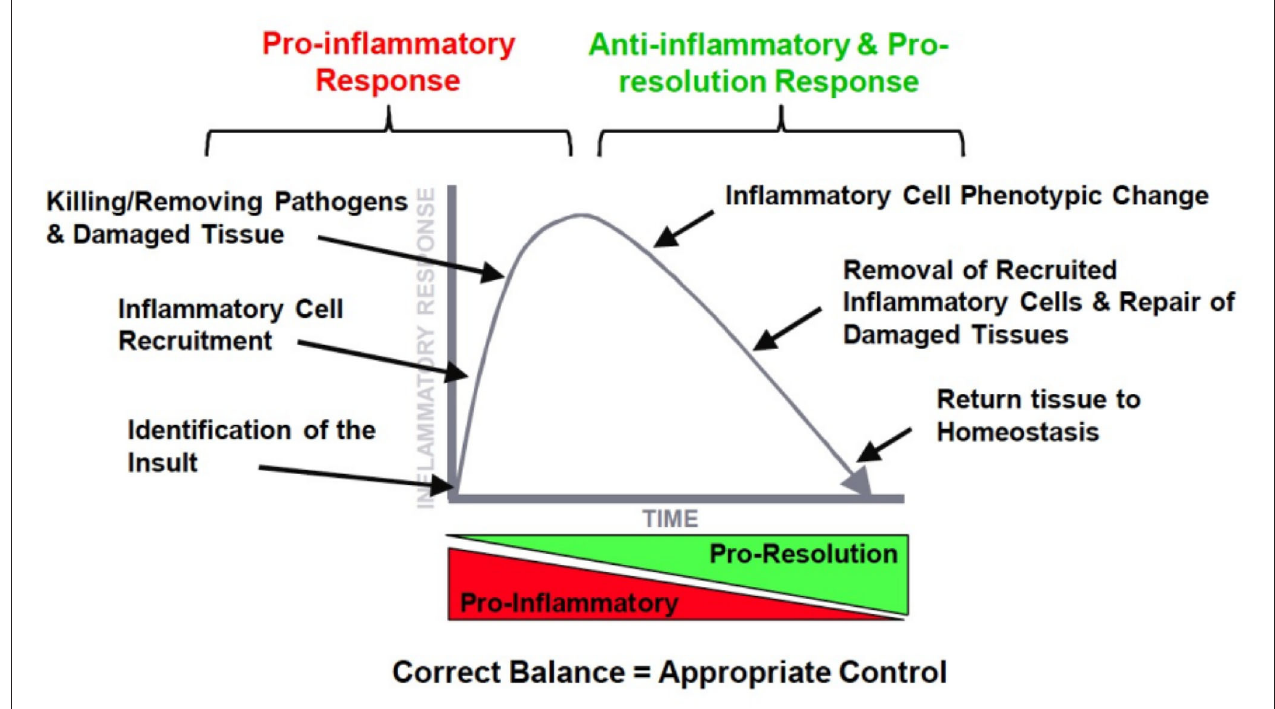
FIGURE 2 | The ideal orchestration of the inflammatory response with an initial pro-inflammatory response and resolution of this response by inflammatory